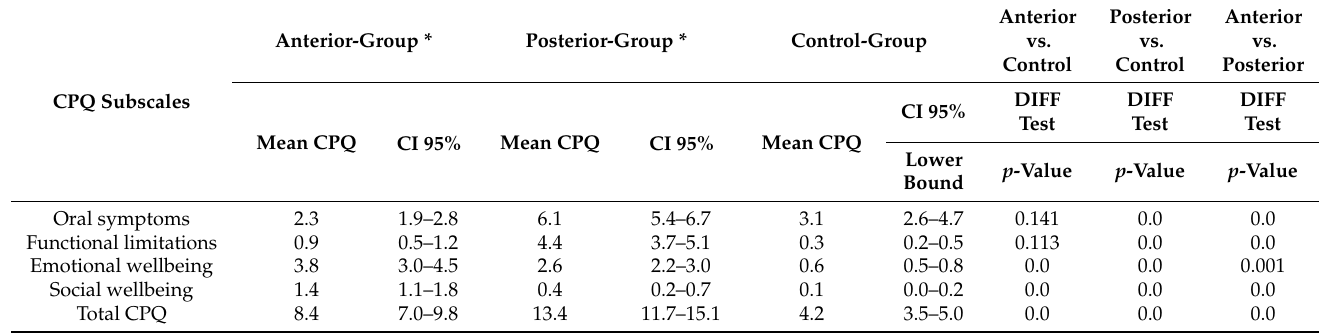
Table 3. Mean and confidence intervals for scores in each CPQ subscale of the Anterior-, Posterior- and